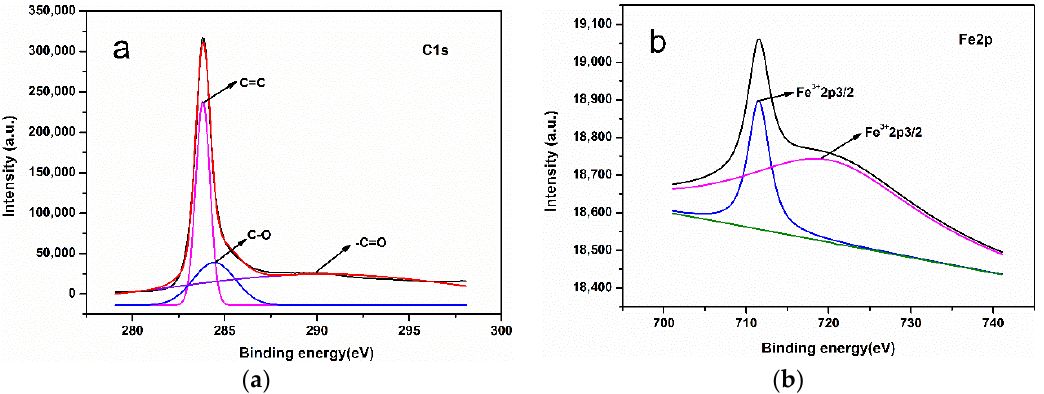
Figure 5. XPS of self-assembled nano-Fe 3 C@RGO aerogel: ( a ) C1s spectra and ( b ) Fe2p spectra.